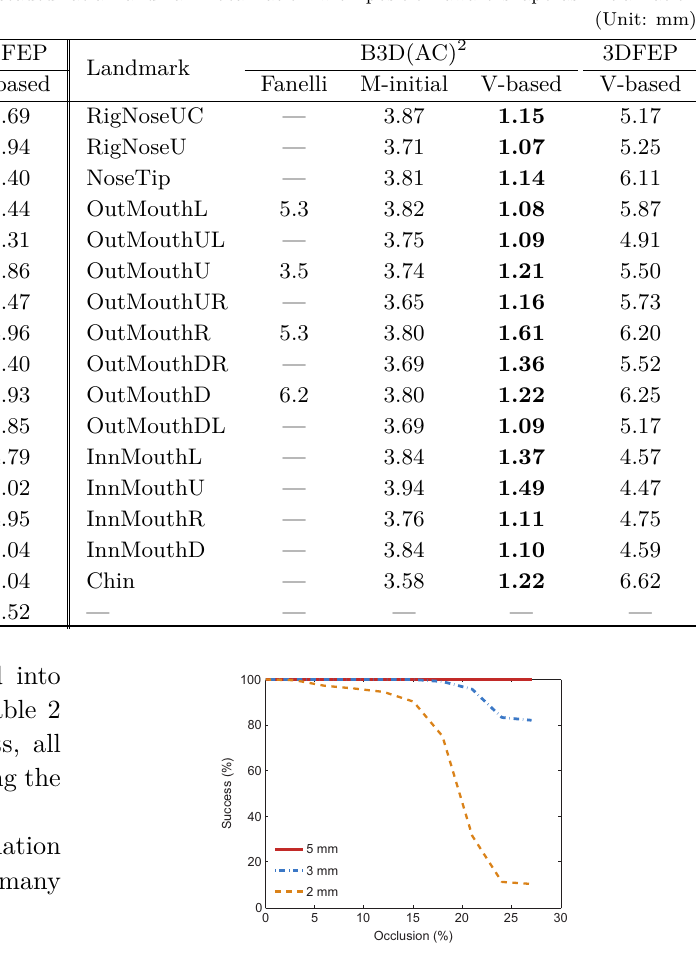
Estimation errors for facial landmark localization for B3D(AC) 2 and 3DFEP databases. M-initial: cascaded facial landmark localization with mean shape as initialization. V-based: cascaded facial landmark localization with position aware shape as initialization